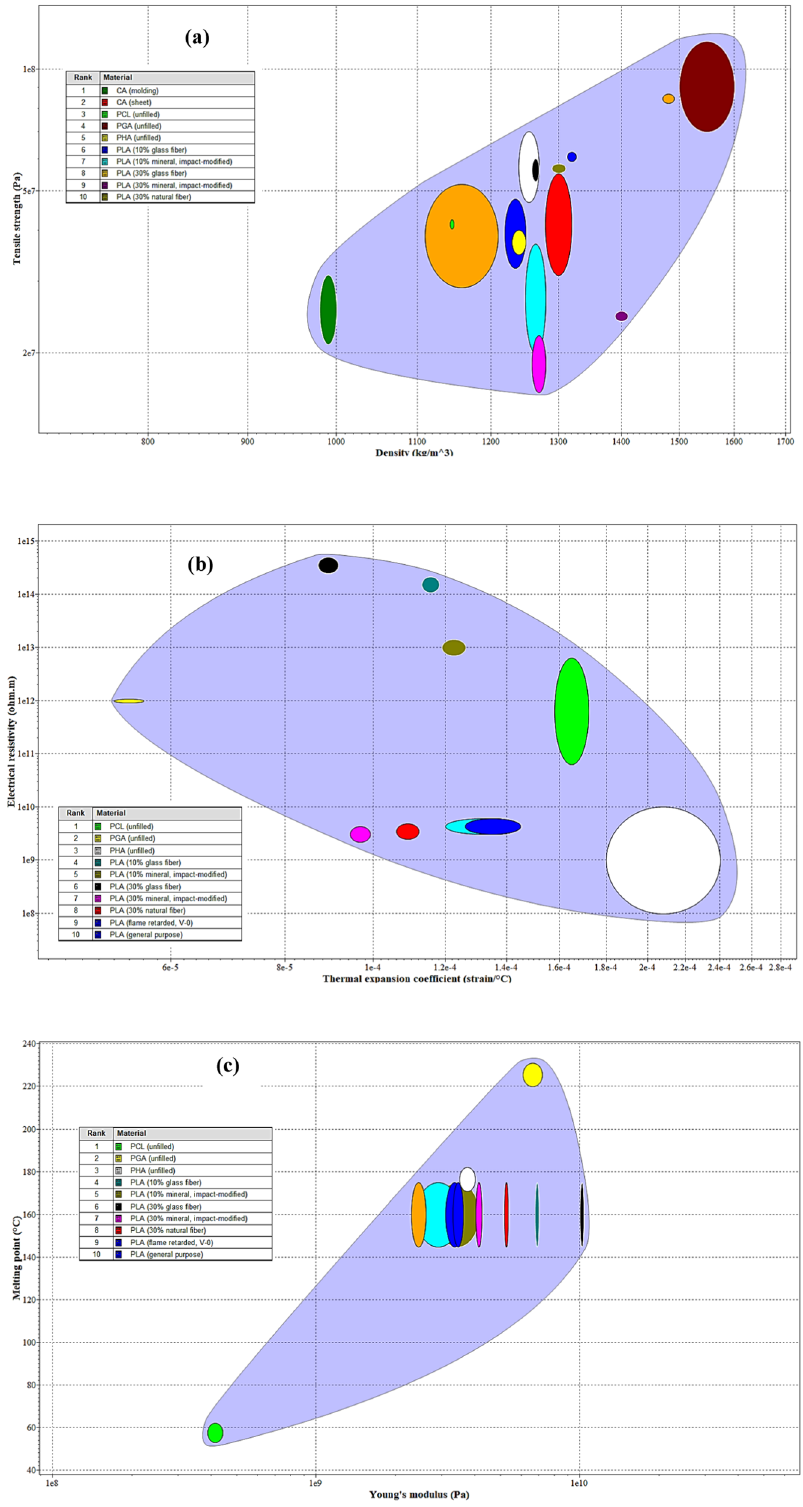
Fig. 2 Properties of biodegdable polymers and their composites. a Density vs. tensile strength. b Themal expansion vs. electrical resistivity. c Young ’ s modulus vs. melting Polylactide (PLA) — glass fi ber composites have high elec- in Fig. 2b. Melting temperature of biodegradable polymers is